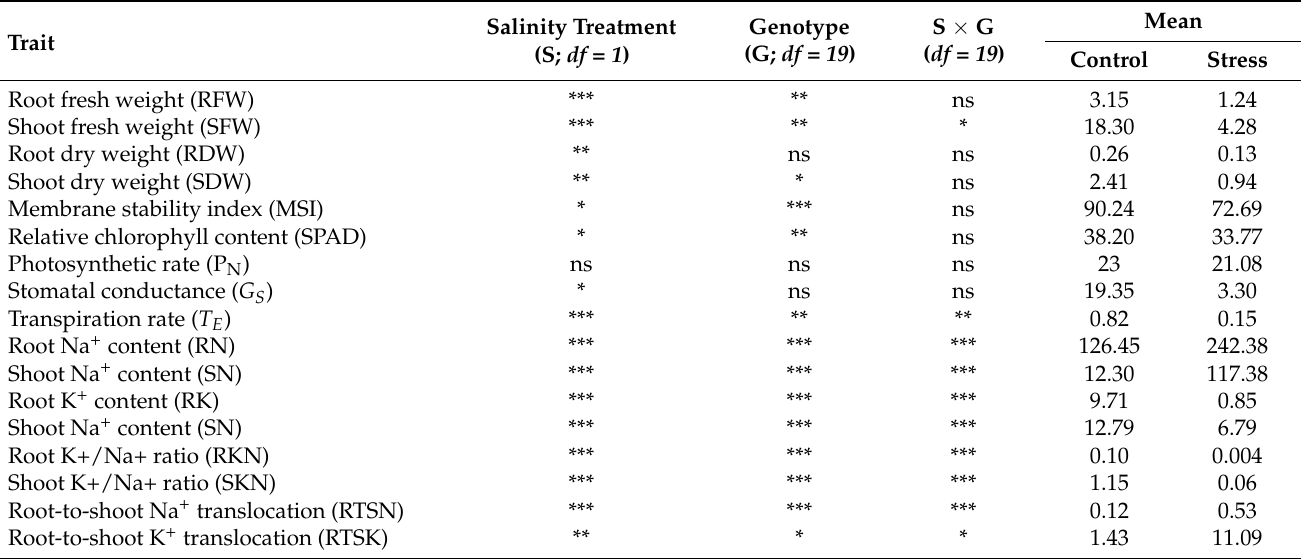
Table 3. The level of probability and mean values for each measured trait in 20 barley genotypes under control and salinity stress